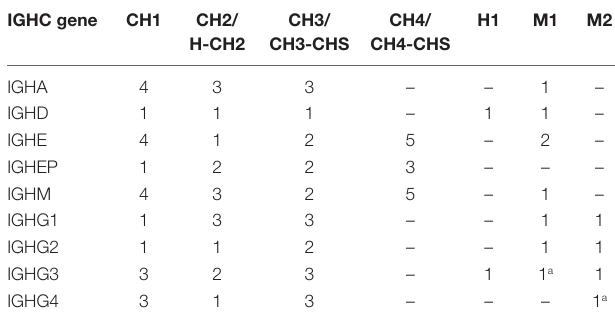
The a indicates that two copies of the gene are found in the macaque genome.